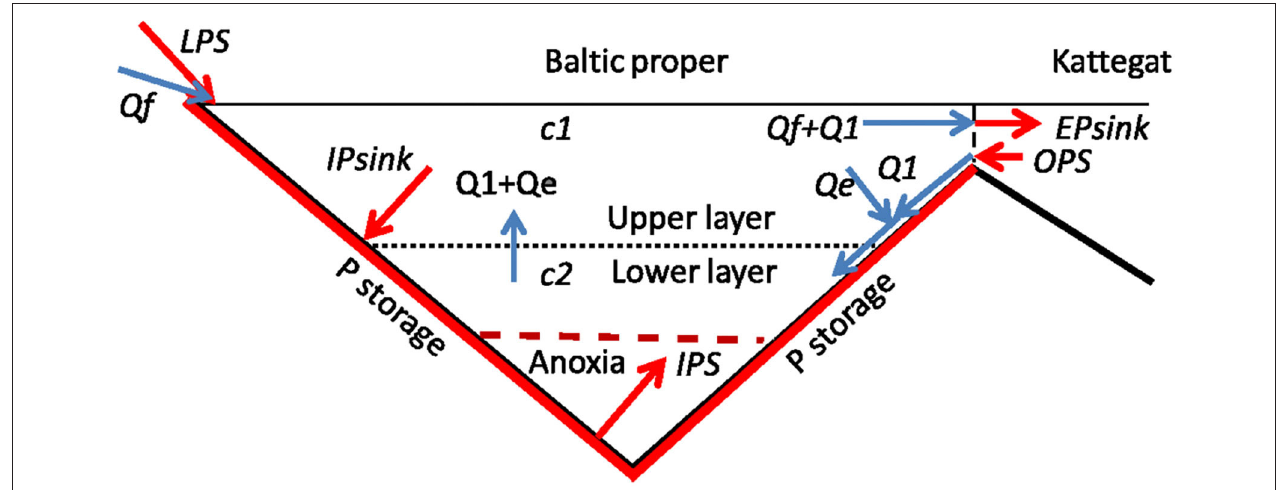
FIGURE 5 | Essential features of the phosphorus model. Phosphorus fluxes from sources and to sinks are shown by red arrows and water fluxes by blue arrows. Red bottoms indicate possible locations of phosphorus storage. Qf , is freshwater supply; Q1 , supply of Kattegat water; Qe , entrained flow from upper to lower layer; c1 ( c2 ), mean winter P concentration in upper (lower) layer; LPS , the land-based P source; OPS , the ocean-based P source; IPS , the internal P source from anoxic bottoms; IPsink , the internal P sink; EPsink , the external P